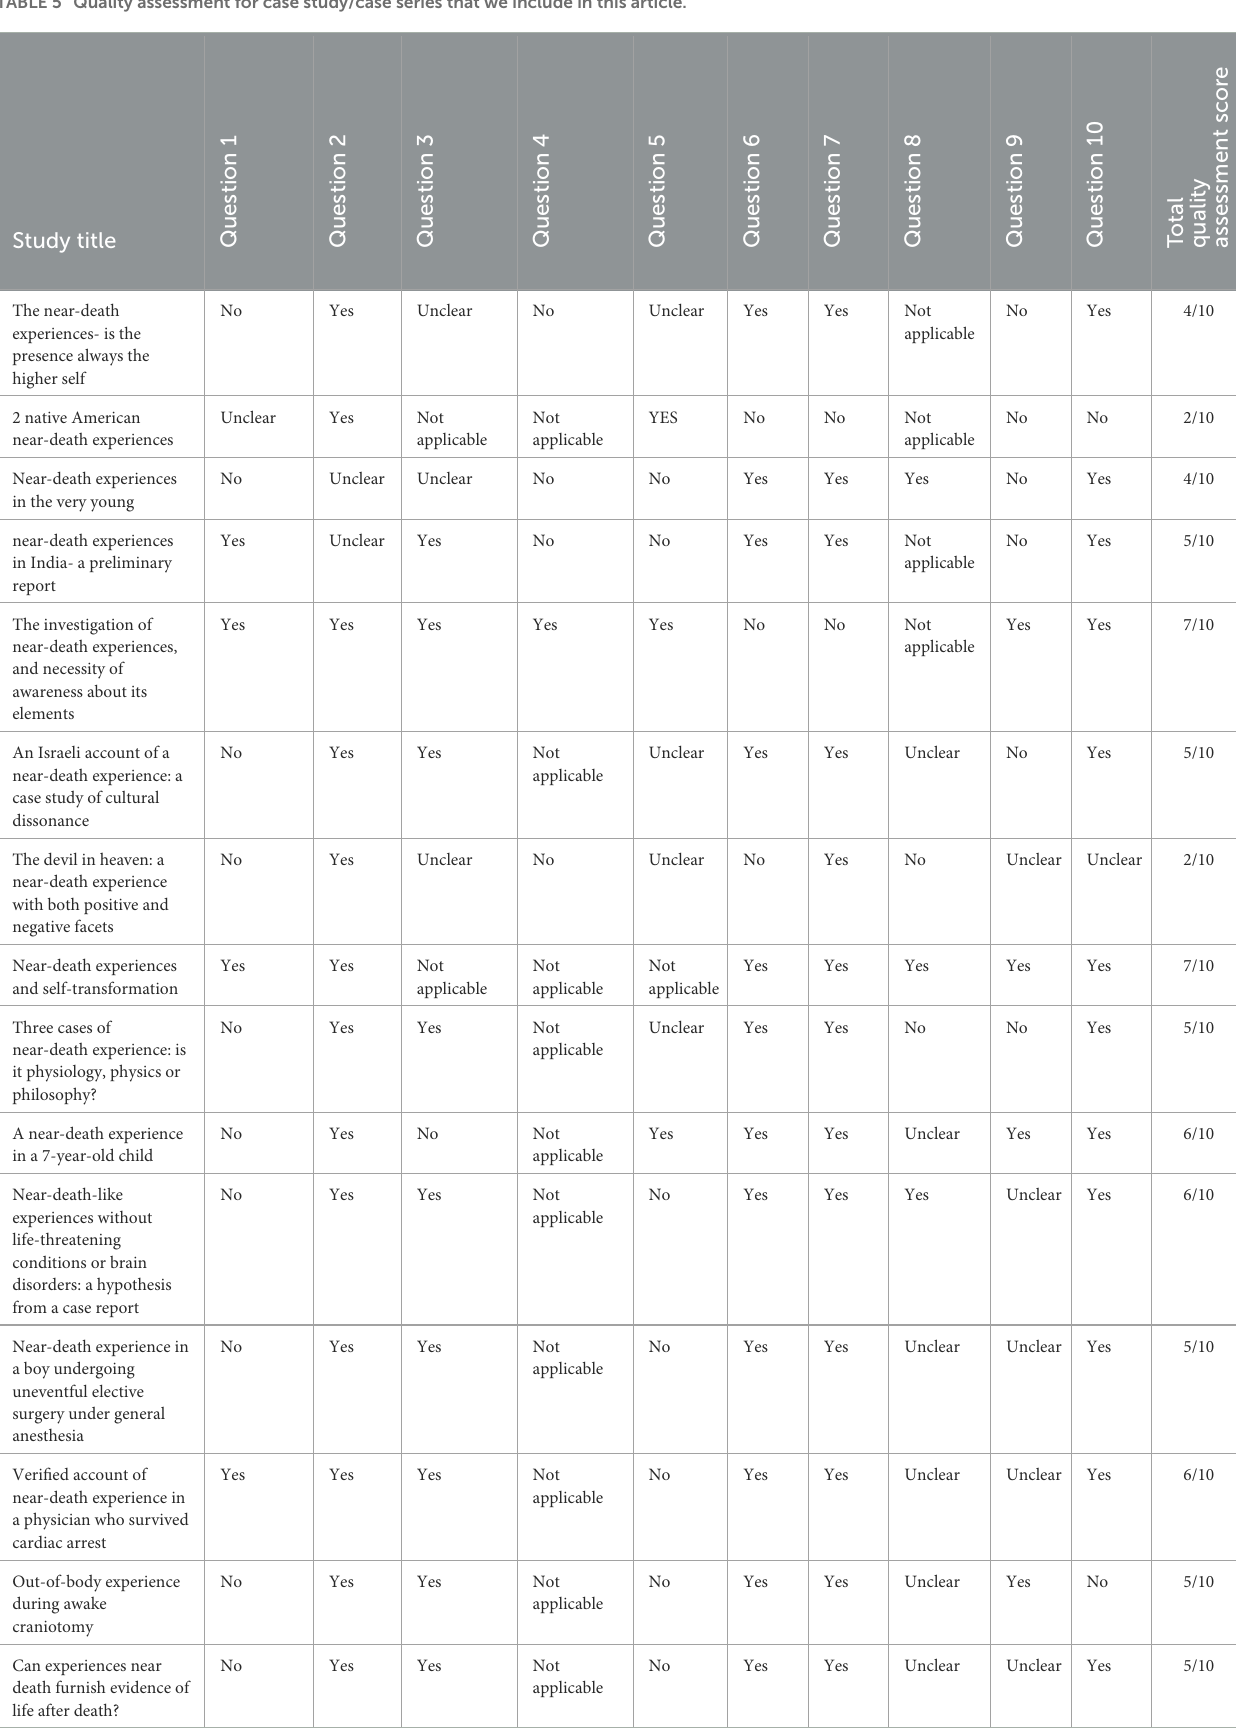
TABLE 5 Quality assessment for case study/case series that we include in this